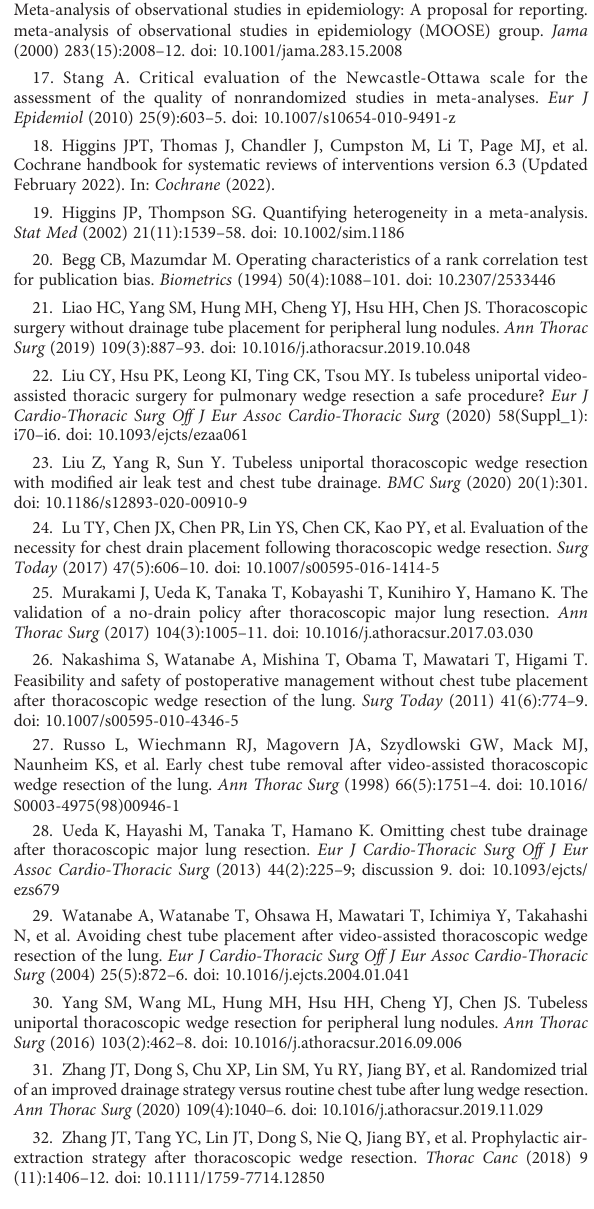
SUPPLEMENTARY FIGURE 2 Sensitivity analyses of outcomes. (A) Postoperative LOS; (B) Pneumothorax; (C) Pleural effusion; (D) Subcutaneous emphysema; (E) Reintervention rate; (F) Pain score on POD 1; (G) Operation duration; (H) Wound healing satisfaction. CI, con fi dence